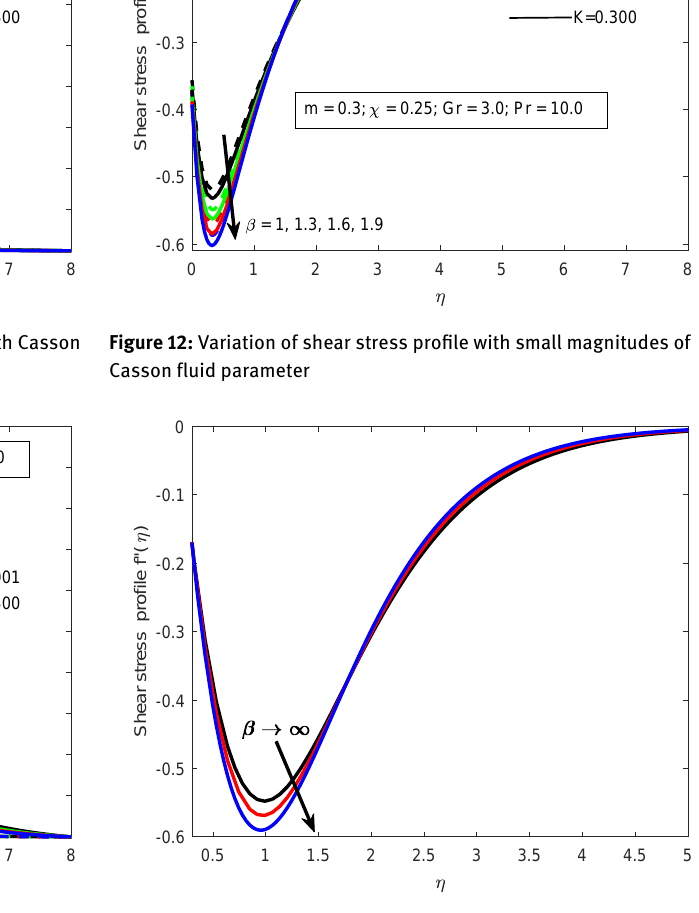
Figure 11: Variation of velocity profile in the z -direction with Casson fluid parameter